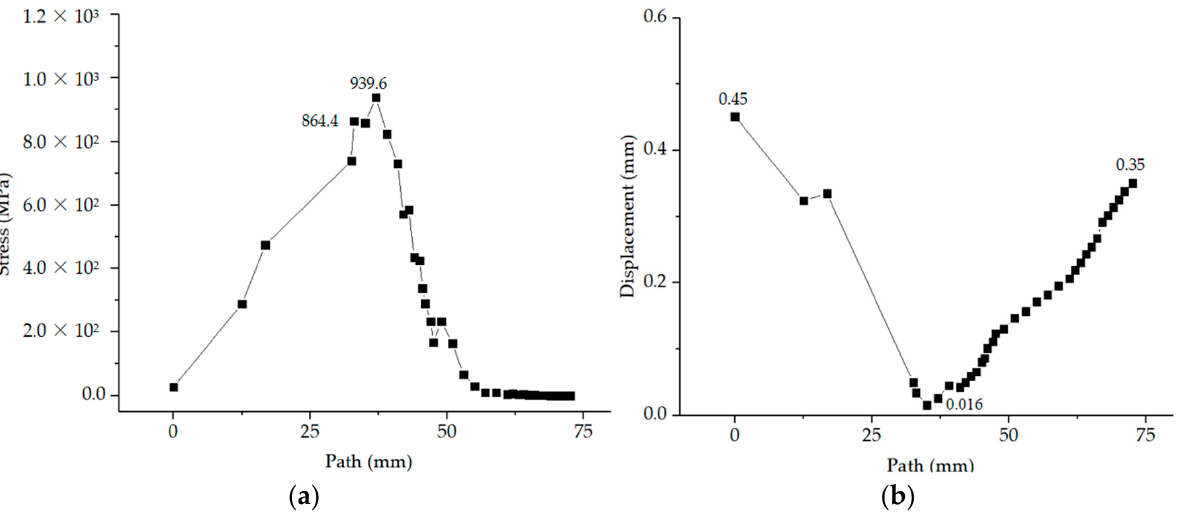
Figure 10. Stress and Displacement Line Chart along Bolt Path under Di ff erent Loads: ( a ) Fracture line diagram of UDHSB path stress under seismic load; ( b ) Line diagram of path displacement of UDHSB under seismic load.